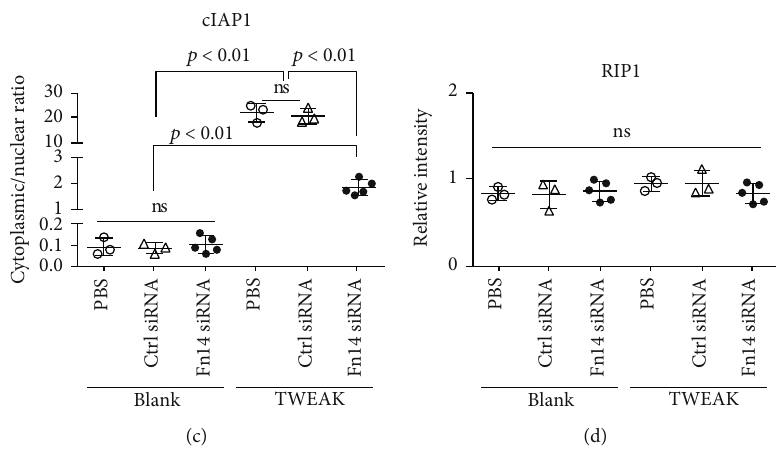
Figure 6: The e ff ect of TWEAK/Fn14 interaction on cytoplasmic import of cIAP1 in TNFR2-overexpressing keratinocytes. Primary human keratinocytes were cultured in vitro . TNFR2-overexpressing keratinocytes were constructed using a retroviral vector. Some cells were pretransfected with siRNA against Fn14 or a control target and then received 48h stimulation with TWEAK (100ng/ml). (a) The distribution of cIAP1 was analyzed in cells via immuno fl uorescent staining. (b) The expression of cIAP1 or RIP1 protein was determined in cell lysates or cytoplasmic (or nuclear) fraction via Western blot. In the bottom of this panel, ubiquitinated RIP1 was detected by immunoprecipitation with anti-RIP1 IgG and then antiubiquitin IgG. (c, d) The band intensities of cIAP1 and RIP1 were measured with ImageJ. Data were obtained from fi ve independent experiments. Representative images are shown. Scale bar = 5 μ m . ns: not signi fi